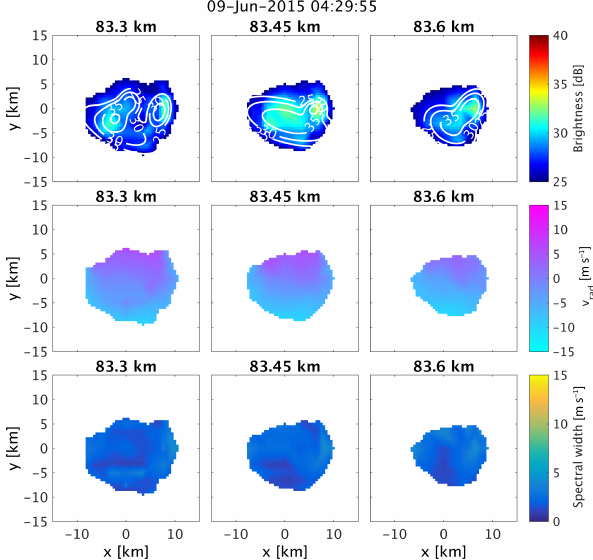
Figure 5. Same as Fig. 4 but for 04:29:55UTC and around